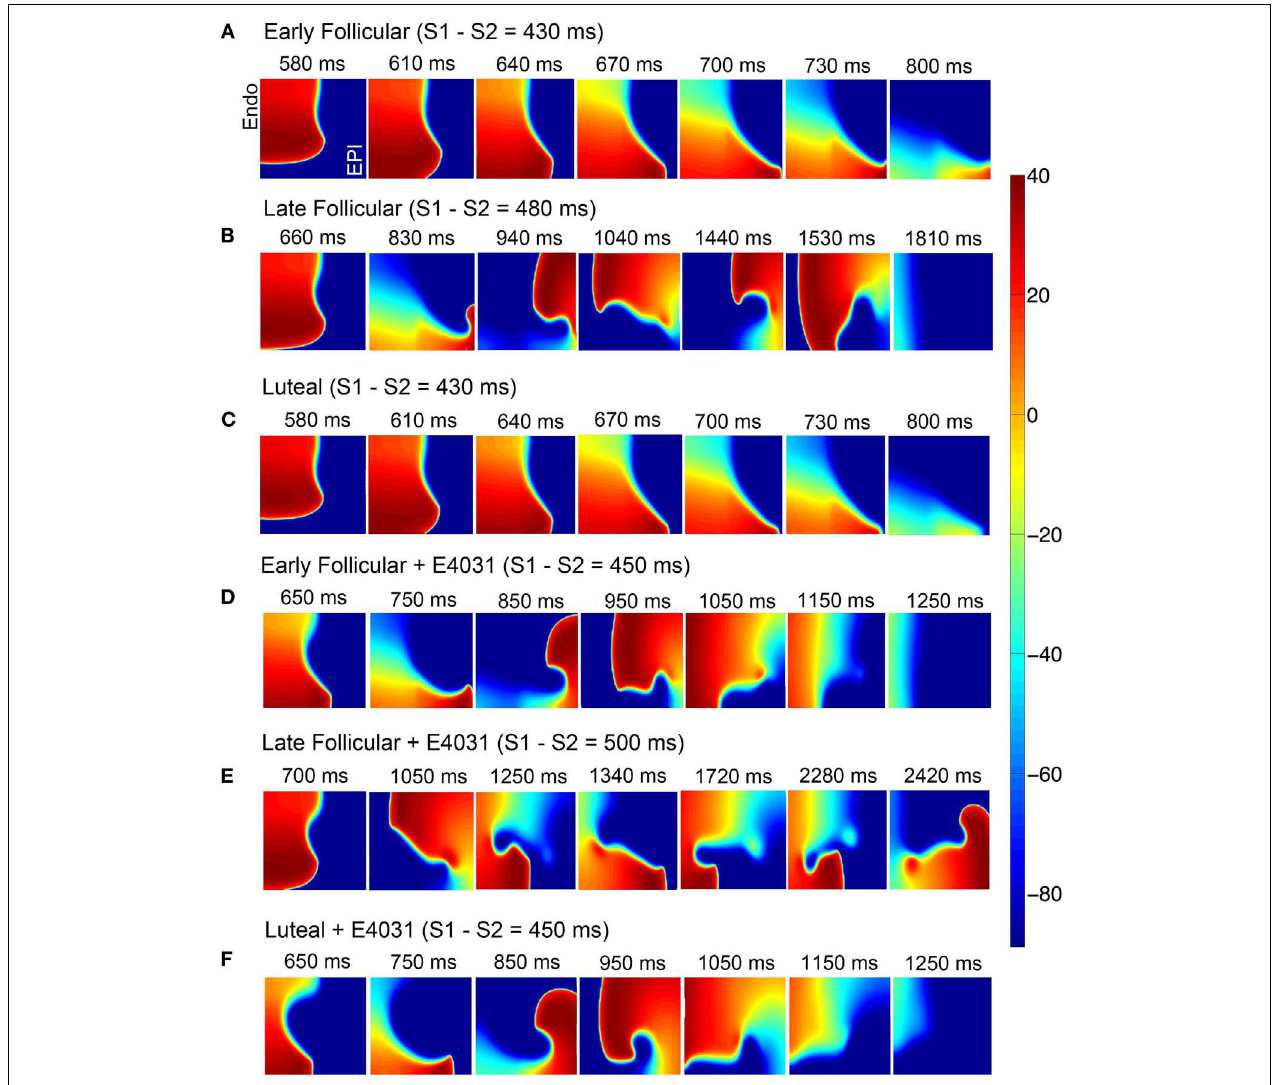
FIGURE 7 | During SNS stimulations simulated reentry wave on female heterogeneous tissues in the presence of female hormones (A–C) and I Kr blocker (D–F). Time pointes and menstrual cycle phases are indicated.The protocol was as in Figure 5